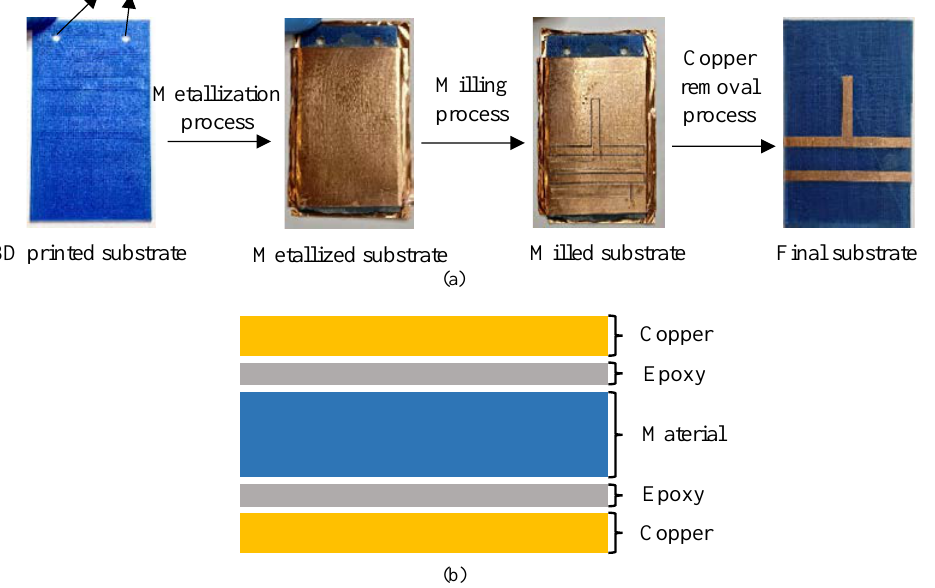
Figure 3. ( a ) Printed circuit board manufacturing process. ( b ) Printed circuit structure of the different materials.